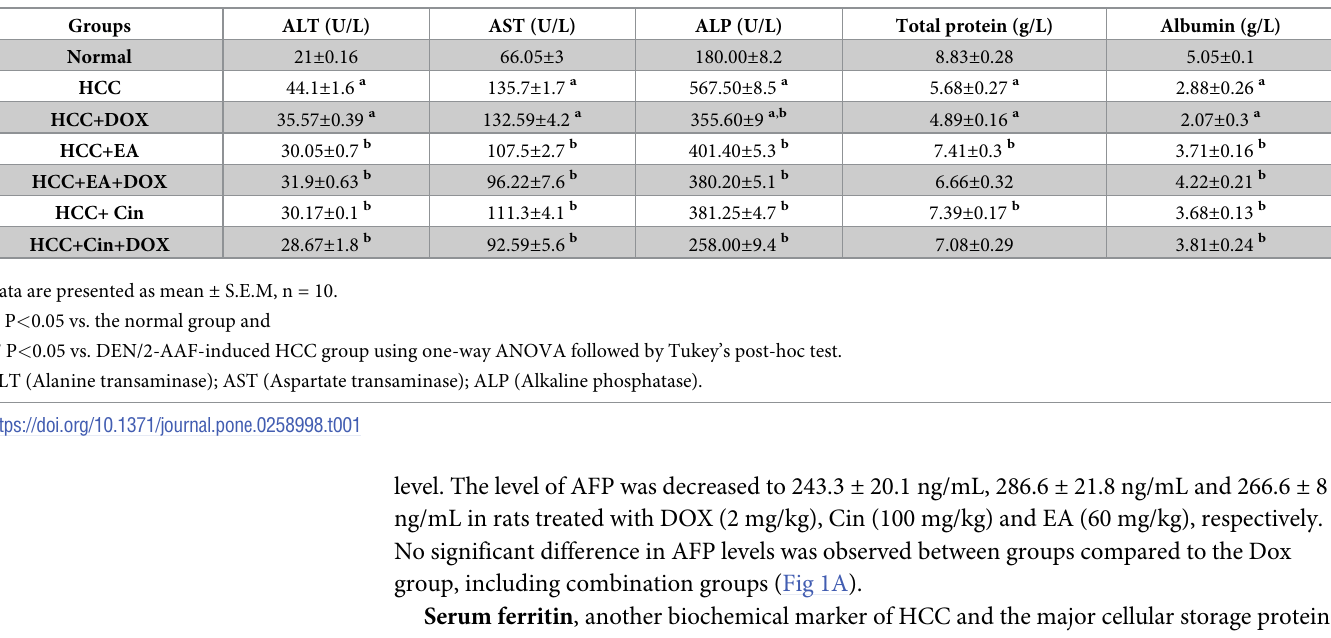
for iron, was elevated to about two folds (234 ± 4 ng/ml) after DEN/2-AAF induction of HCC compared to normal rats (112 ± 3.5 ng/mL). This elevation was opposed by all treatment